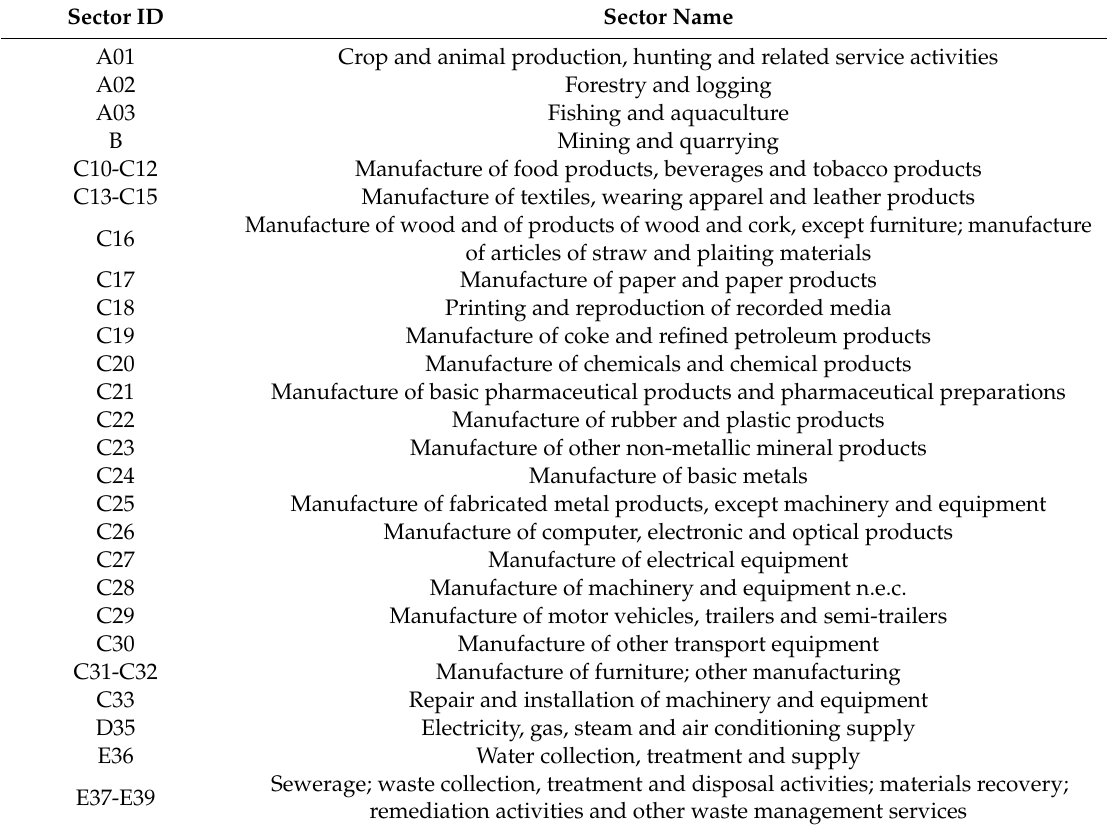
Table A1. Sector classification in national I–O analysis in World Input–Output Database